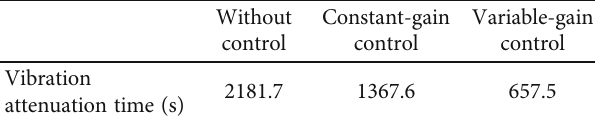
Table 1: The vibration attenuation times of the simulation